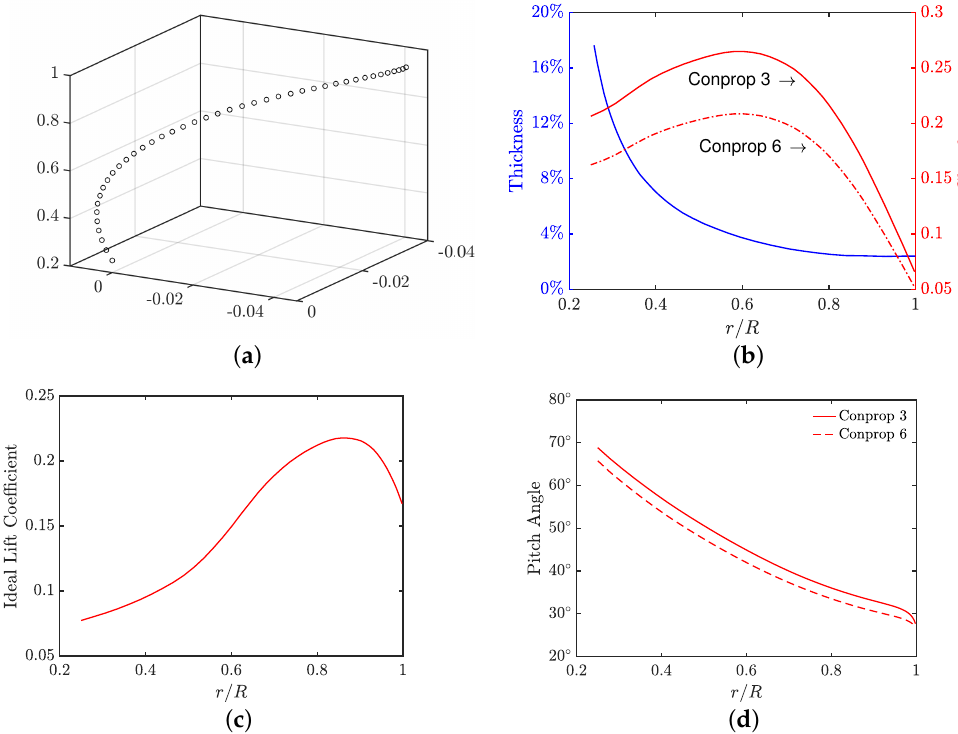
Figure 4. The sectional distributions of the classical propellers, Conprop-3 and Conprop-6: ( a ) the stacking line, ( b ) the chord and thickness, ( c ) the ideal lift coefficient and ( d ) the pitch